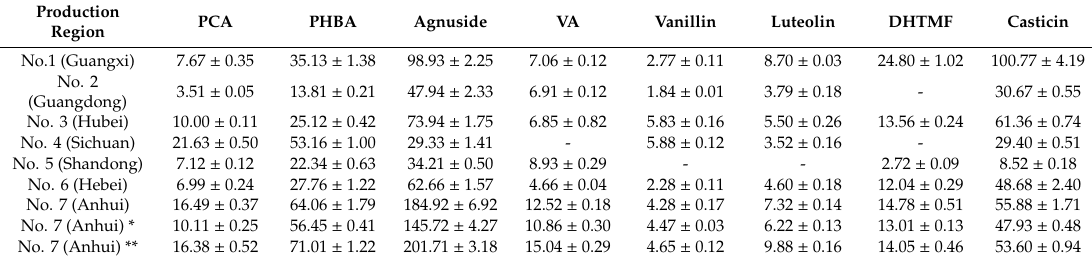
Table 4. Contents of the 8 compounds of VF from 7 batches. Average contents (mg / 100g) with their standard deviations, n = 3